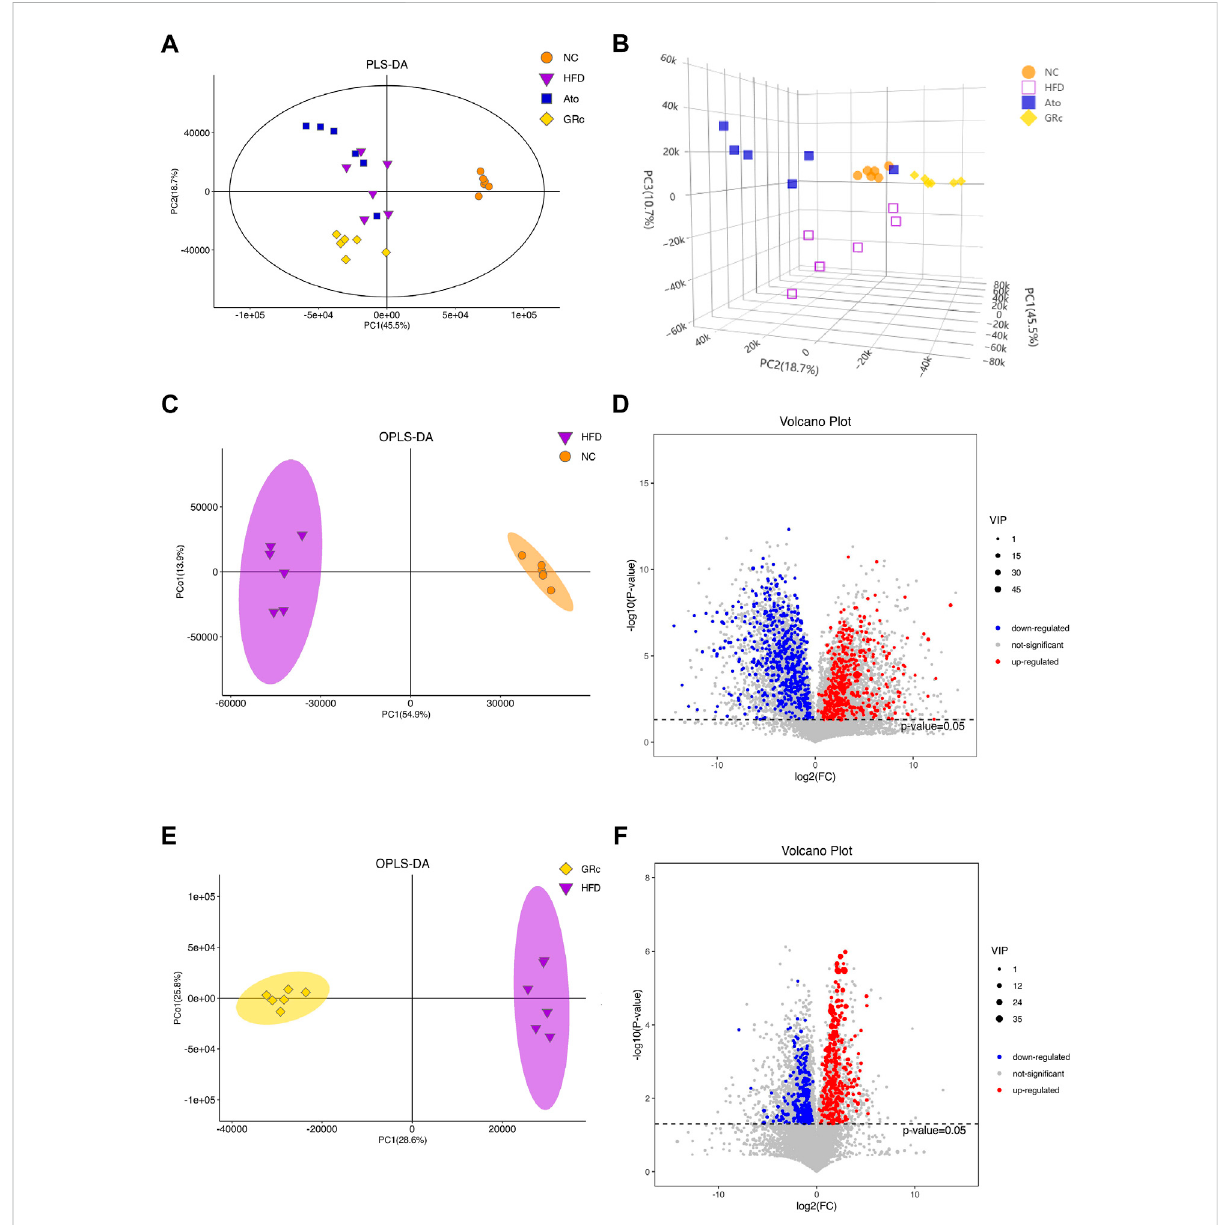
FIGURE 7 GRc modulated the fecal metabolites in ApoE − / − mice ( n = 6). (A) Two-dimensional PLS-DA score plots per group. (B) Three-dimensional PLS- DA score plots per group. (C) OPLS-DA score plot inNCand HFDgroups. (D) Relative volcano plot inNCand HFDgroups. (E) OPLS-DA score plotin GRc and HFD groups. (F) Relative volcano plot in GRc and HFD groups. NC, normal control; HFD, high-fat diet; Ato, atorvastatin; GRc, ginsenoside